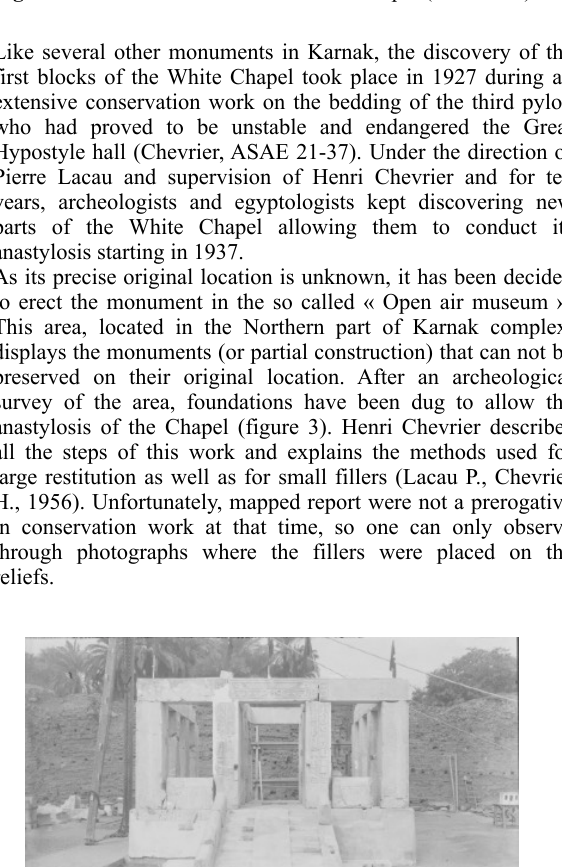
Figure 2 . North-East view of the White Chapel (June 2021)